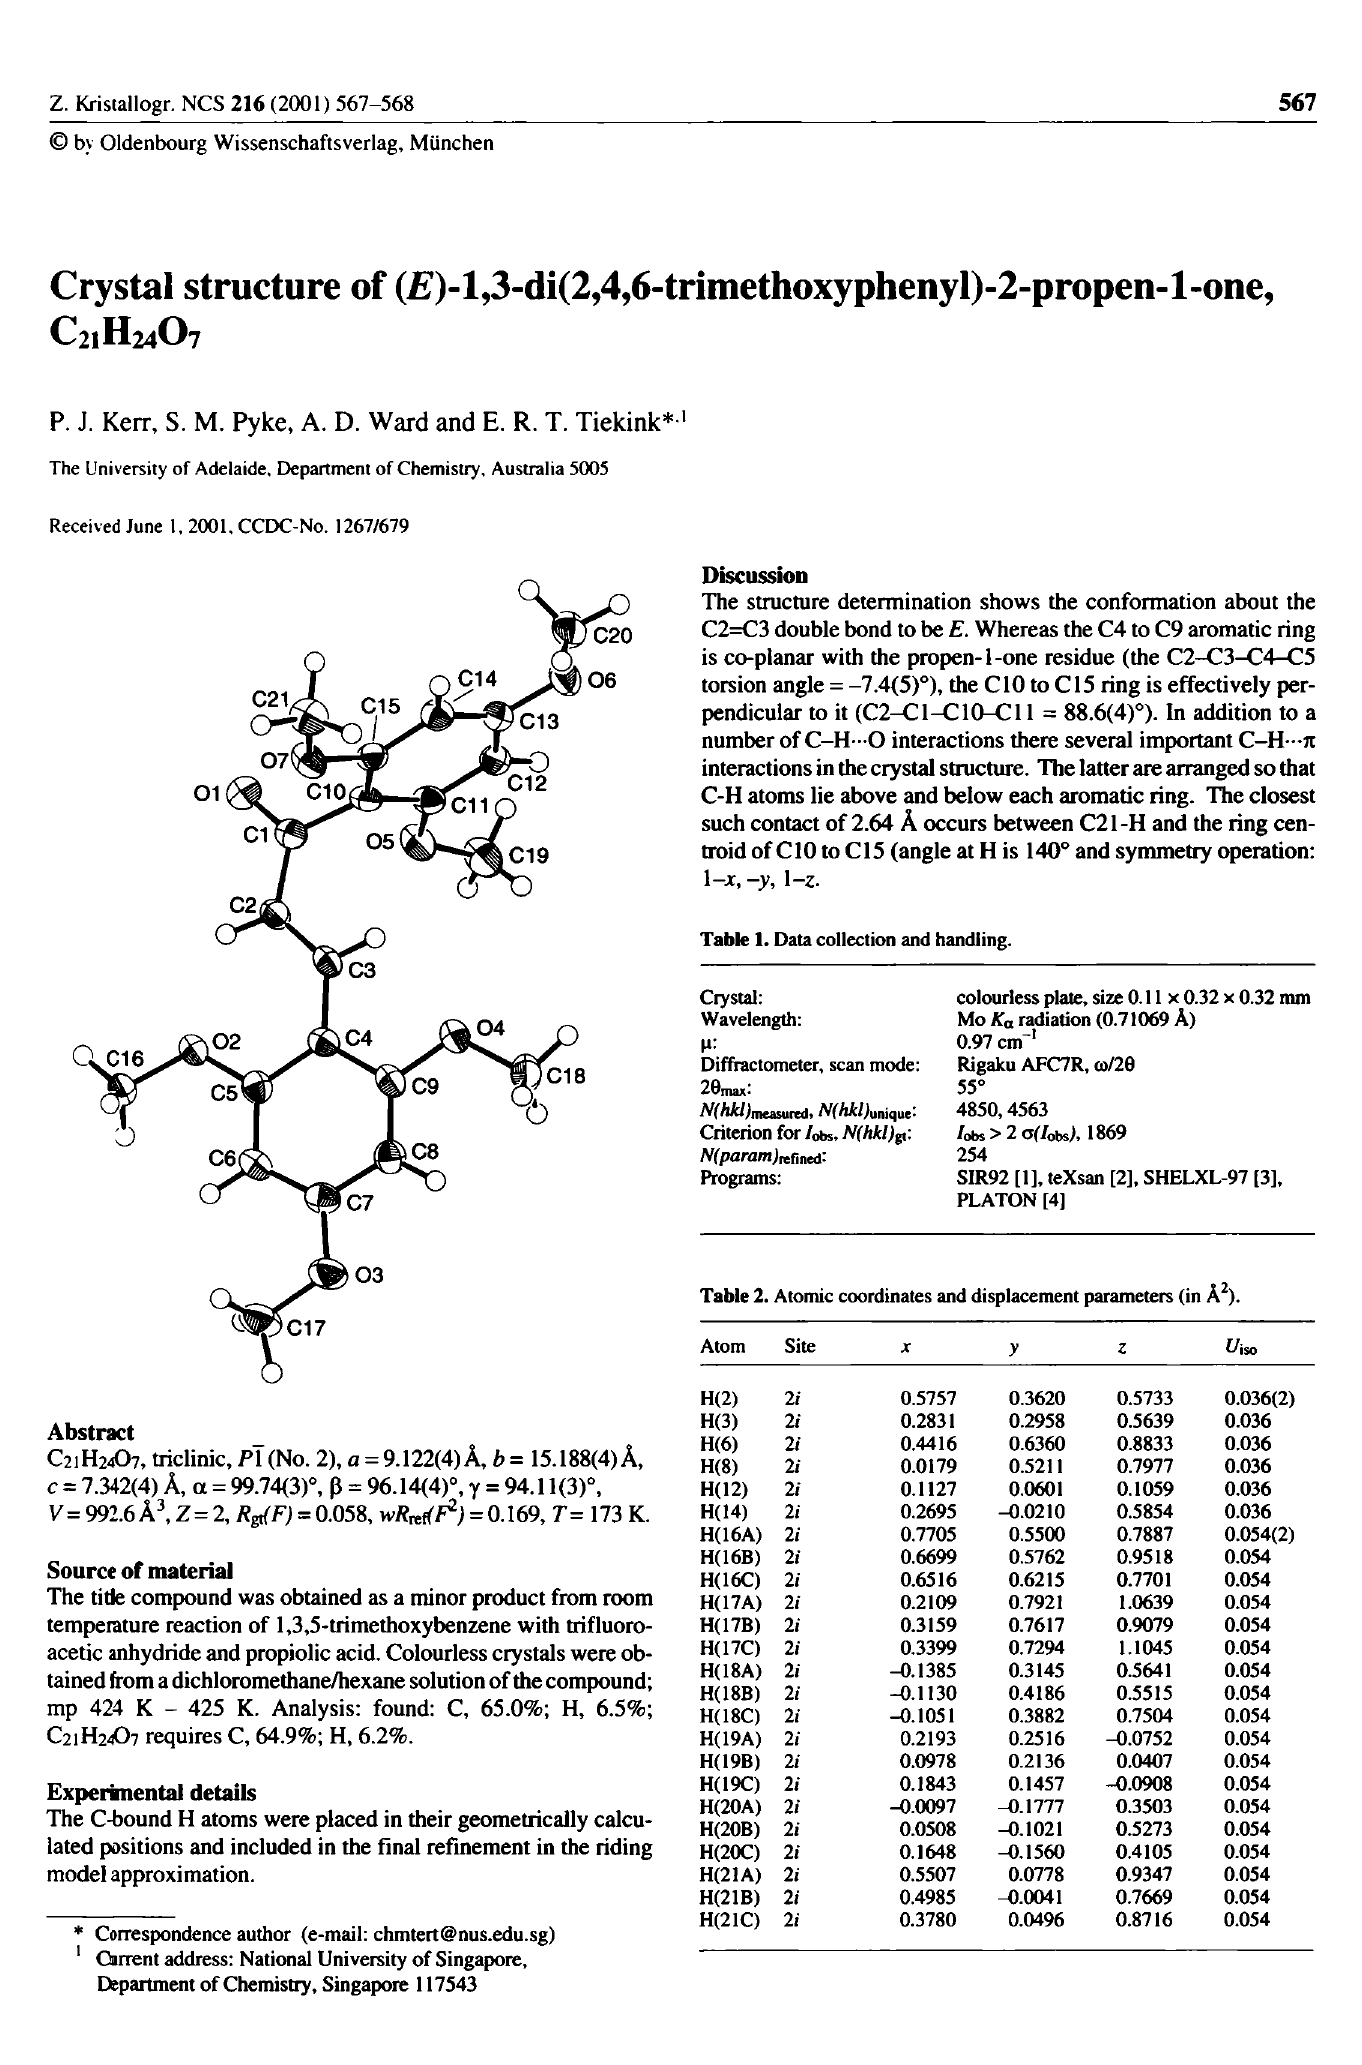
Table 2. Atomic coordinates and displacement parameters (in Ä 2